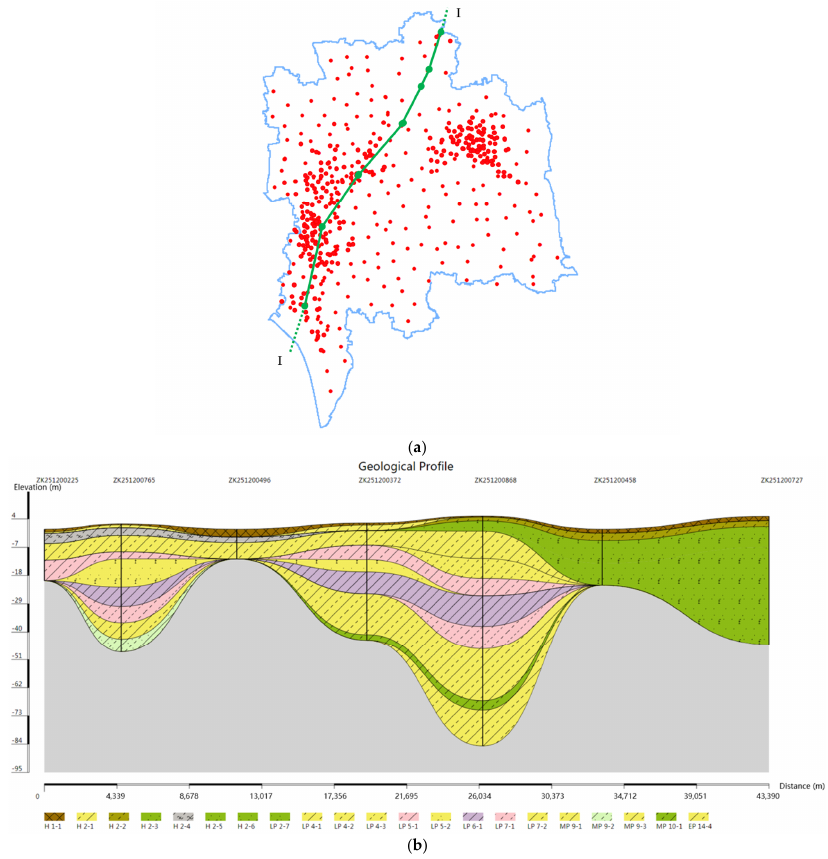
Figure 6. Geological profile I and its location. ( a ) Borehole locations and line connecting boreholes; ( b ) Geological profile I corresponding to drilling line I in ( a ) by unique path method (legend text corresponds to Table 2).